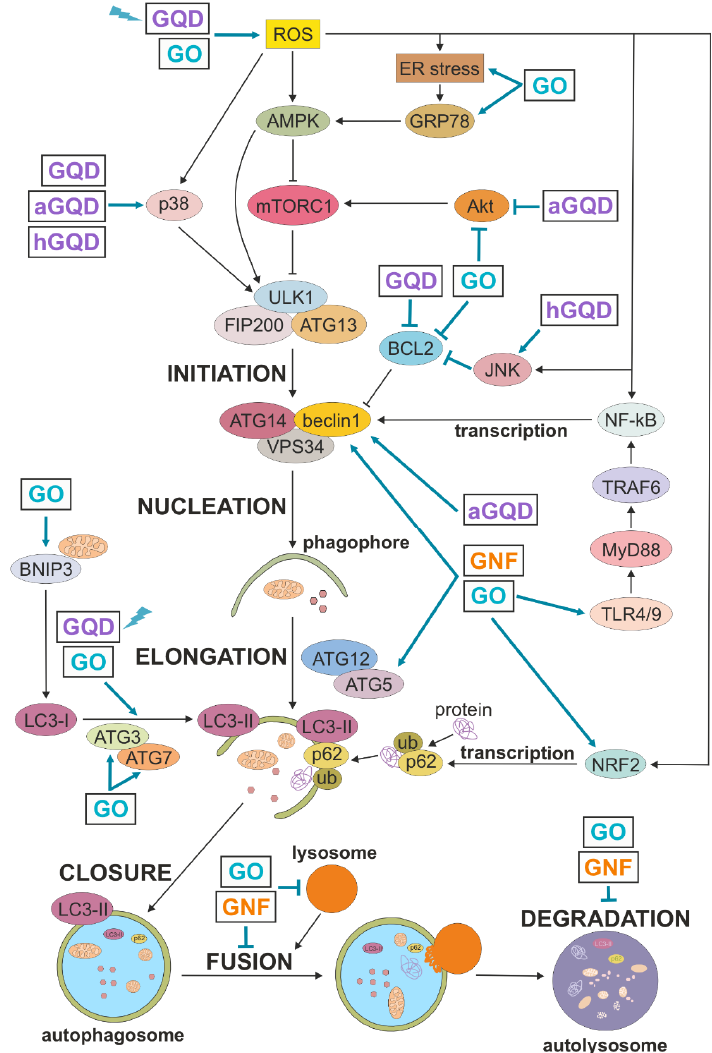
Figure 3. Autophagy regulation and its modulation by GNM. A simplified map of autophagy regulation is presented, including the sites of action of GNM shown as arrow-headed (activation/increase) or bar-headed lines (inhibition/decrease). GQD and GO are shown to directly modulate LC3 con- version because no specific underlying mechanism is described. The presented interactions are described in more detail in the main text. aGQD, amino-GQD; AMPK, AMP-activated protein kinase; ATG, autophagy-related; BCL2, B cell lymphoma 2; BNIP3, BCL2-interacting protein 3; ER, endoplas- mic reticulum; FIP200, focal adhesion kinase family interacting protein of 200 kD; GNF, graphene nanofibers; GO, graphene oxide; GQD, graphene quantum dots; GRP78, glucose-regulated protein 78; hGQD, hydroxy-GQD; JNK, c-Jun N-terminal kinase; LC3, microtubule-associated light chain 3; NF- κ B, nuclear factor- κ B; NRF2, nuclear factor erythroid 2-related factor 2; mTORC1, mechanistic target of rapamycin complex 1; MyD88, myeloid differentiation factor 88; ROS, reactive oxygen species; TLR, Toll-like receptor; TRAF6, TNF receptor associated factor 6; ub, ubiquitin; ULK1, Unc-51-like kinase 1; VPS34, vacuolar protein sorting 34; lightning symbol denotes photoexcitation. Autophagy regulates cancer cell death in a complex, context-dependent manner, dis- playing either cytotoxic or cytoprotective actions determined by the cell type,